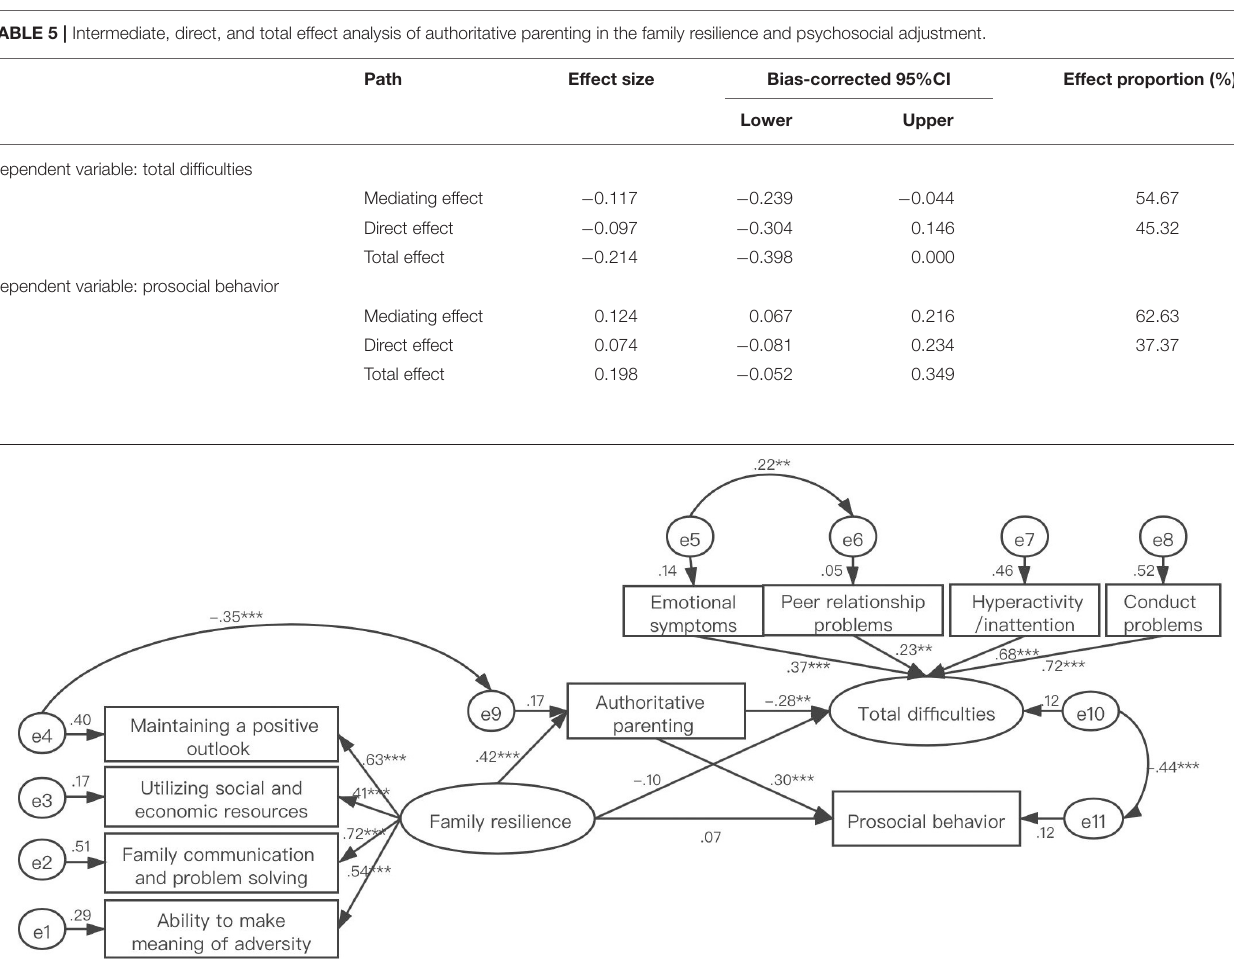
FIGURE 1 | Structural equation model of family resilience, authoritative parenting and psychosocial adjustment. Types of chronic illness as control